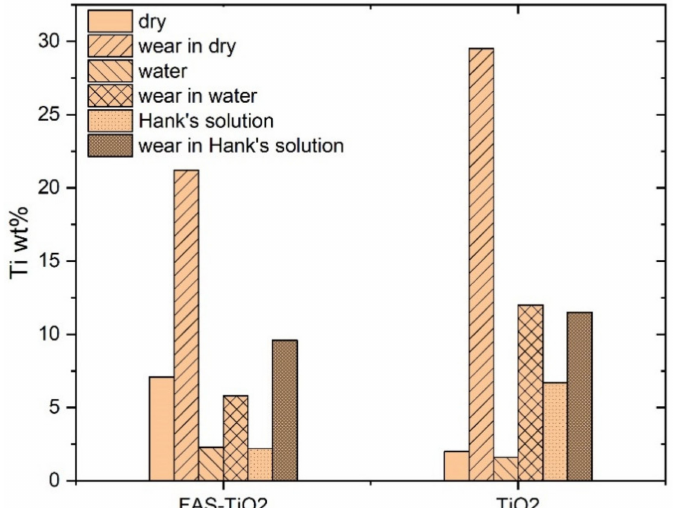
Figure 5. Wear tracks for FAS-TiO 2 coating; ( a ) dry sliding, ( b ) sliding in distilled water and ( c ) sliding in Hank’s solution. Squares mark the EDS measurement sites.